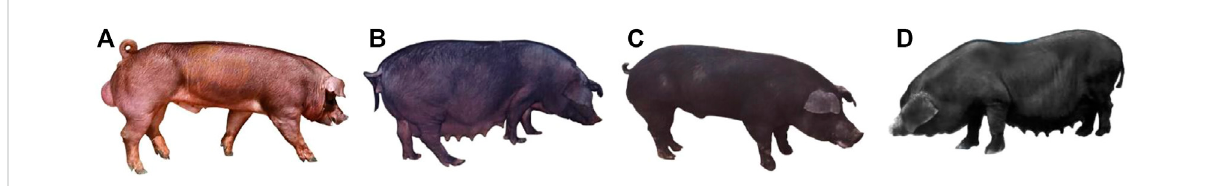
FIGURE 1 Yunan, Huainan, and Duroc used in this study. (A) Duroc. (B,C) Yunan (D)